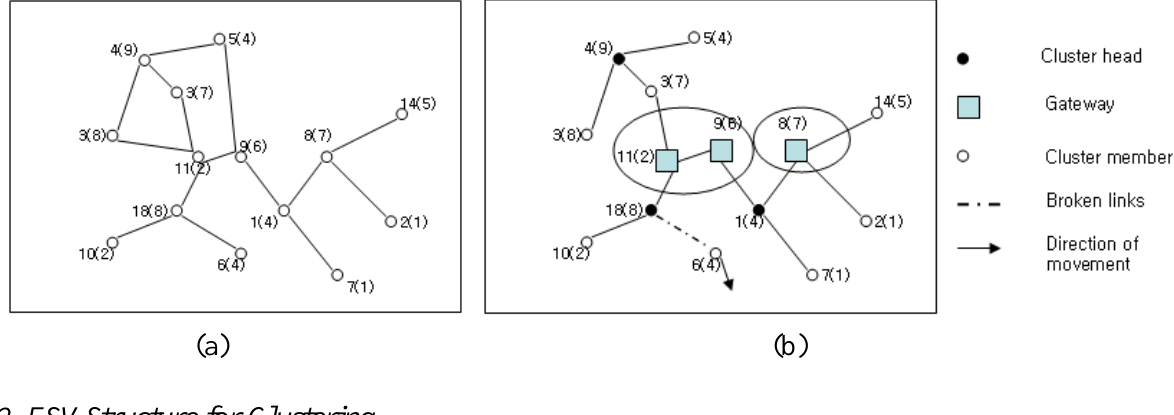
Figure 1. Flat structure and Hierarchical structure. ( a ) Flat structure. ( b ) Hierarchical structure.